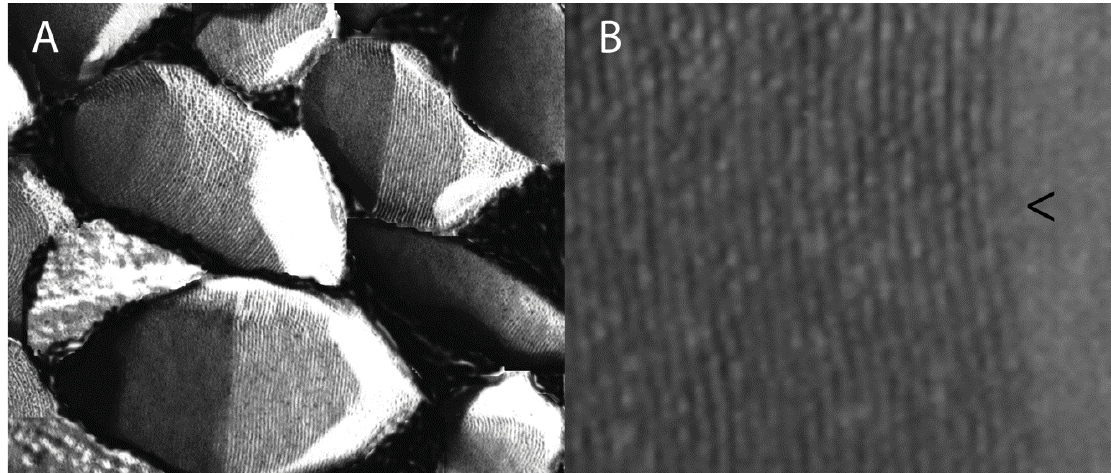
Figure 1. ( A ) Gas vesicle nanoparticles (GVNPs) produced in Halobacterium sp. NRC-1 observed by freeze-fracture electron microscopy; ( B ) Higher magnification shows the ribbed structure formed by a shallow spiral of the protein GvpA and stabilized by the